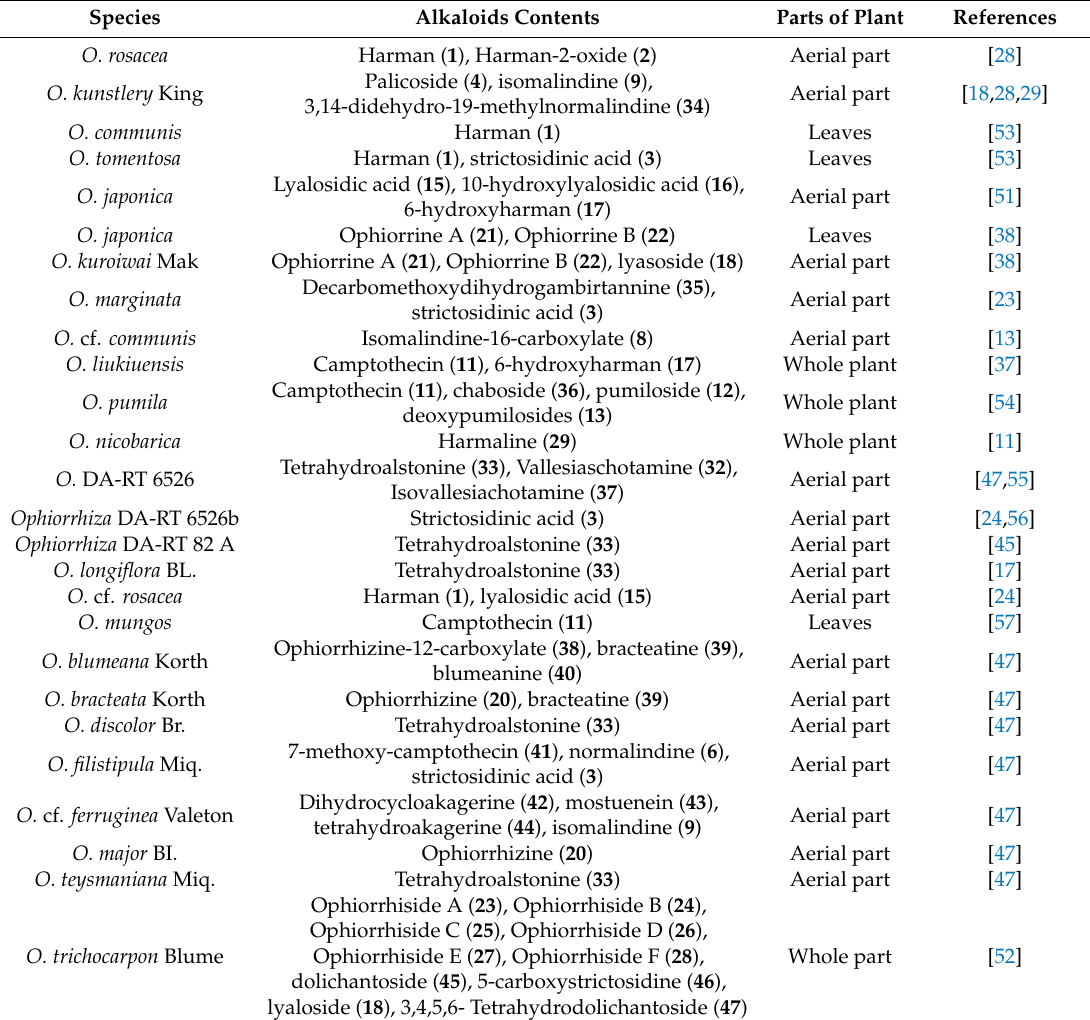
Table 3. Alkaloids contents in Ophiorrhiza